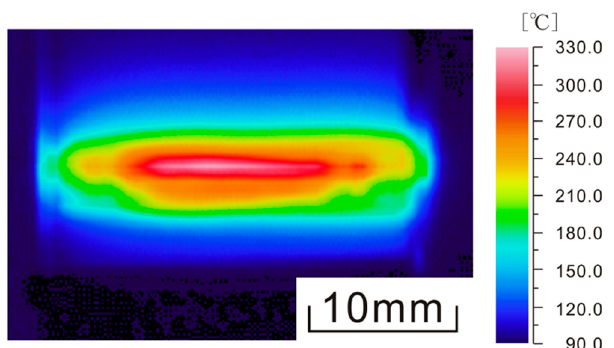
Figure 12. Thermal image of the welded zone measured by the thermograph.